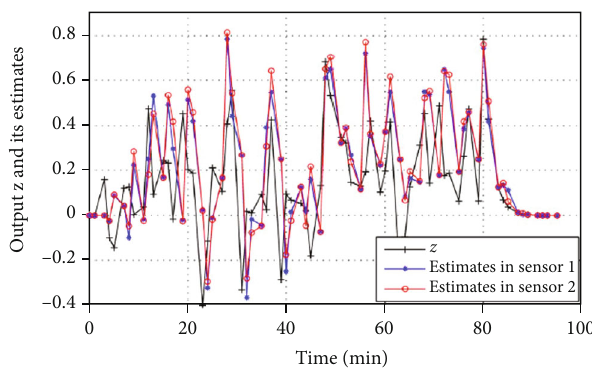
Figure 2: Absolute error between actual route and predictive